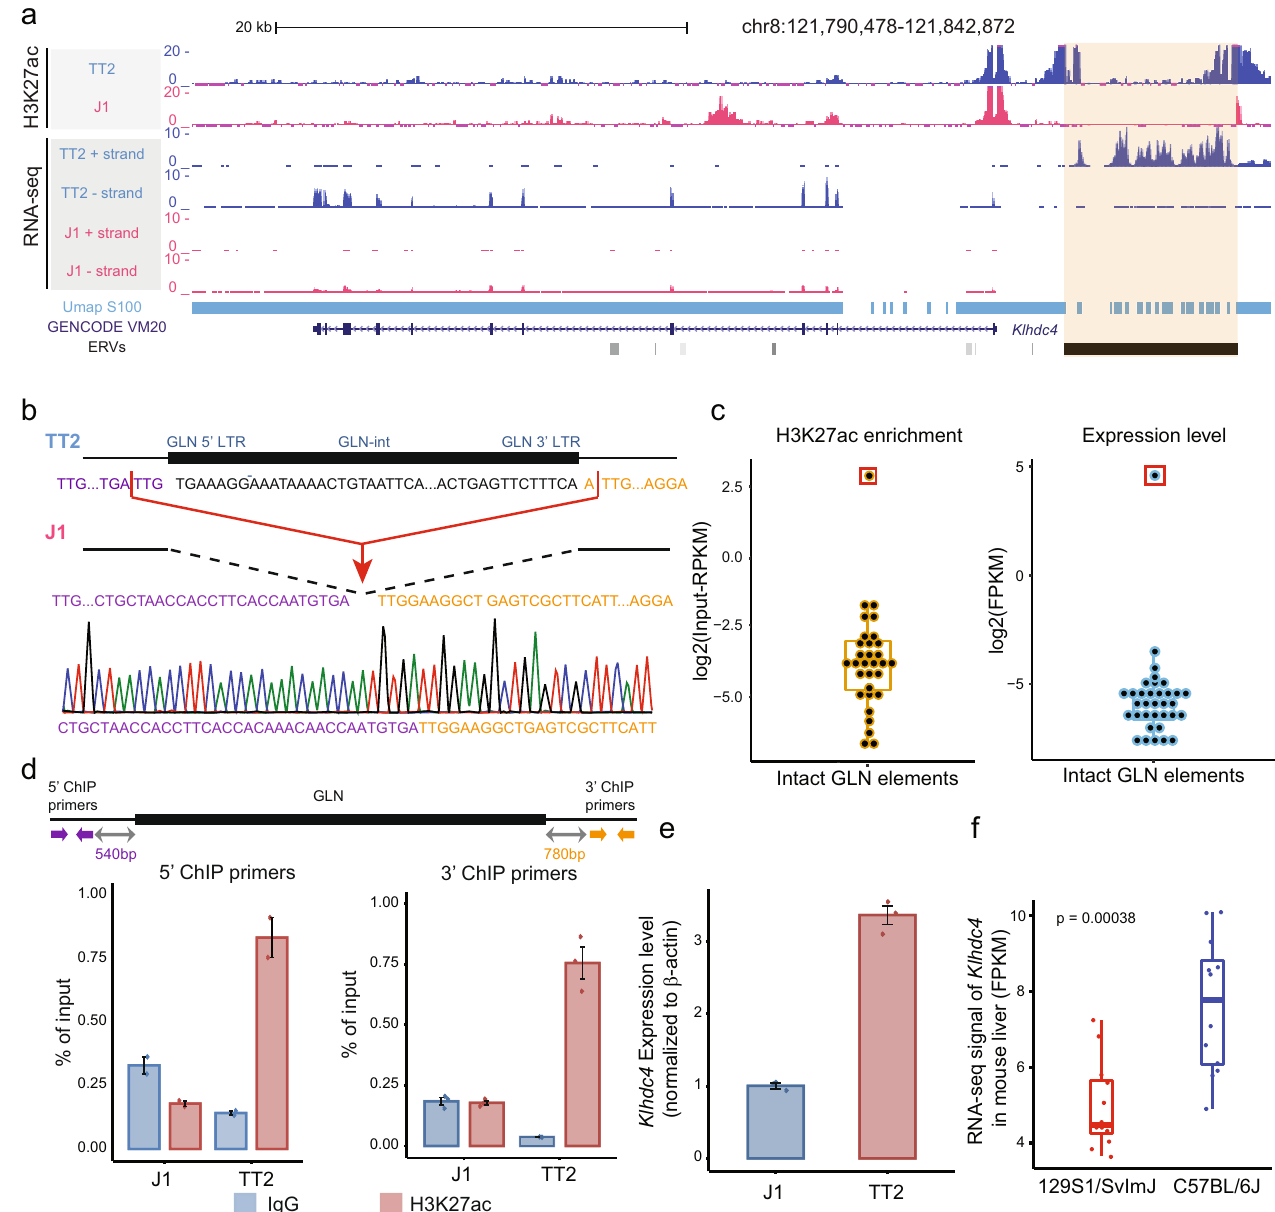
−5.0−2.50.02.520 TTG...TGA TTG TGAAAGGAAATAAAACTGTAATTCA...ACTGAGTTCTTTCA A TTG...AGGA TTG...CTGCTAACCACCTTCACCAATGTGA TTGGAAGGCT GAGTCGCTTCATT...AGGA Fig. 1 Polymorphic GLN integration is associated with the differential epigenomic states and gene expression between distinct genetic backgrounds. a Genome browser screenshot illustrates the presence of a polymorphic GLN element (orange shading) in TT2 and not J1 genomes. The integration is associated with higher H3K27ac enrichment and transcription of both the polymorphic GLN element (on + strand) and the Klhdc4 gene (on − strand) in TT2 cells. ChIP-seq datasets are shown as input-subtracted Reads Per Kilobase per Million reads (Input − RPKM) values and RNA-seq datasets are displayed as Reads Per Million (RPM). The Umap track shows the mappability calculated from single end 100 bp reads. Particular regions within the GLN element have relatively poor mappability. b Schematic illustrates the GLN insertion in the two cell lines and the Sanger sequencing result of the locus in the J1 genomic DNA. LTR: Long Terminal Repeat. c Boxplots of the H3K27ac ChIP-seq (left) and RNA-seq signals (right) of all the intact GLN elements in the mm10 reference assembly ( n = 40). The polymorphic GLN element is marked with a red box. ChIP-seq signals are shown as log2-transformed Input − RPKM values and RNA-seq signals are displayed as log2-transformed Fragments Per Kilobase per Million reads (FPKM). The center and the bounds of boxes refer to the median and quartile of all data points, respectively. The minima and maxima of boxplots indicate quartile 1 − 1.5 × Interquartile range and quartile 3 + 1.5 × interquartile range, respectively. d ChIP-qPCR results demonstrate the increased H3K27ac enrichment at regions 5 ′ (left) and 3 ′ (right) of the polymorphic GLN element in TT2 compared to J1 mESCs. Positions of primers are indicated in the top schematic. IgG is included as a negative control. Error bars re fl ect standard deviations with the centers indicating the means of three technical replicates. e RT-qPCR results validated increased Klhdc4 expression in TT2 compared to J1. Error bars re fl ect standard deviations with the centers indicating the means of three technical replicates. f Boxplot shows the expression level in FPKM of Klhdc4 in the liver of two different mouse strains 44 ( n = 12). The center and bounds of boxes refer to the median and quartile of all data points, respectively. The minima and maxima of boxplots indicate Quartile 1 − 1.5 × interquartile range and Quartile 3 + 1.5 × interquartile range, respectively. P value is calculated by two-tailed T